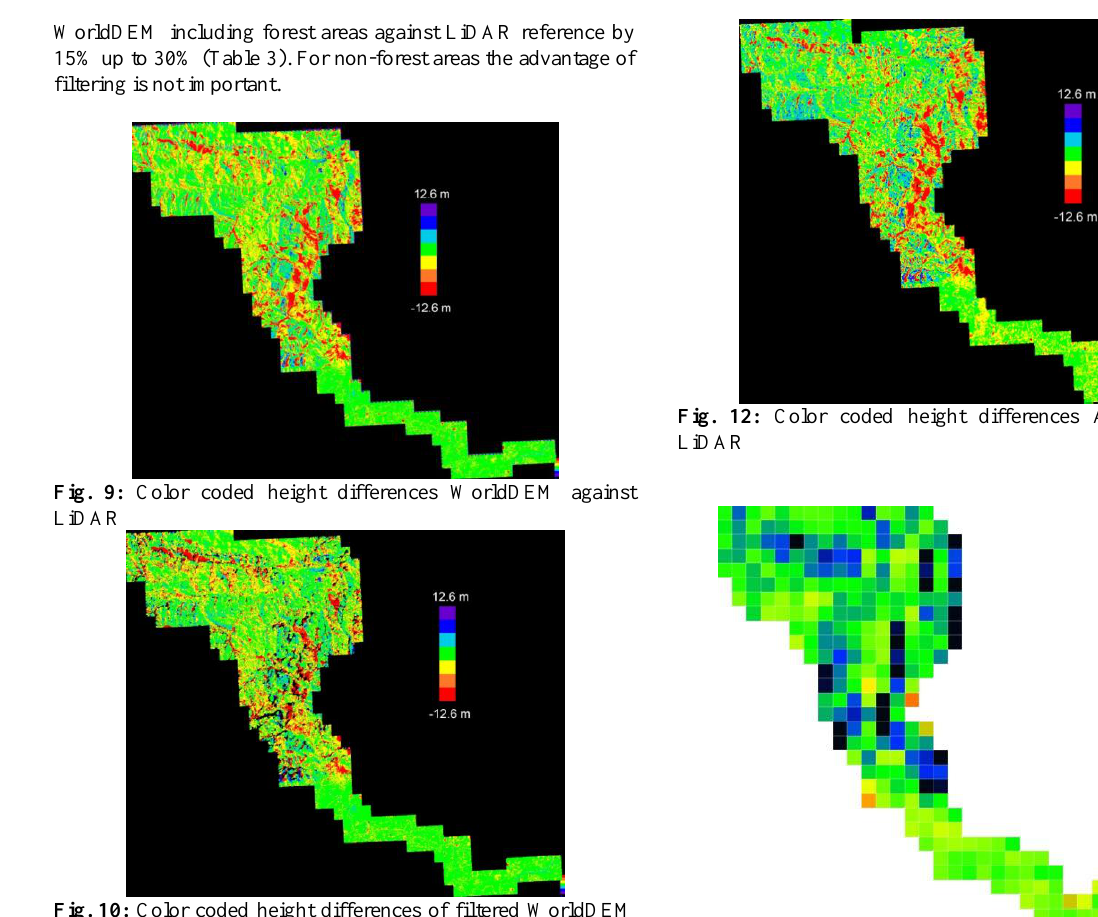
Fig. 13: Color coded systematic errors of WorldDEM against LiDAR reference